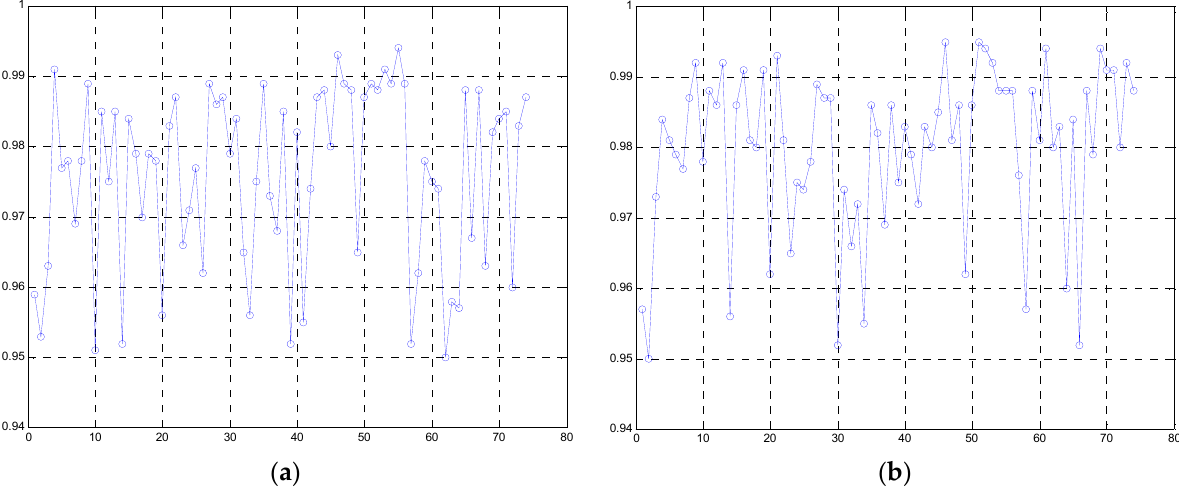
Figure 14. Coherence coefficient of the tie-points in the master and slave SAR images between strips, where ( a ) is the master image and ( b ) is the slave image.